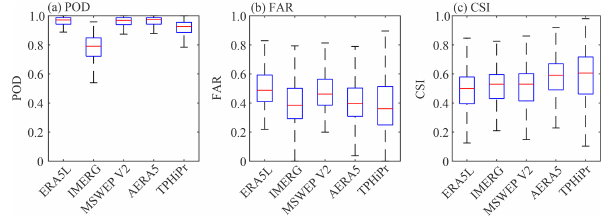
Figure 11. Similar to Fig. 9 but for (a) POD, (b) FAR and (c) CSI. These metrics are calculated using a threshold of 0.1mmd − 1